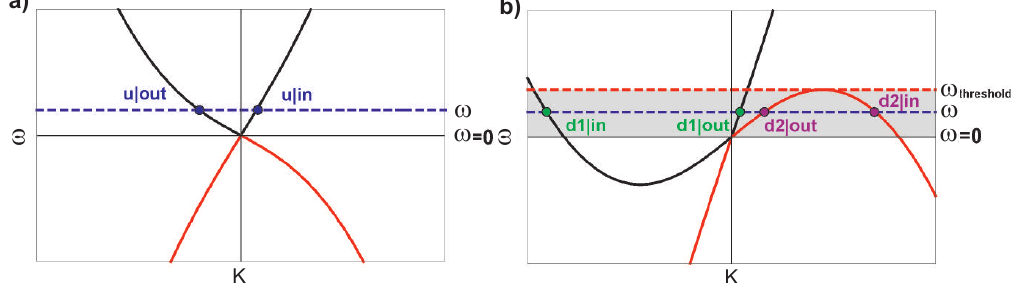
Figure 7: Dispersion relation in the laboratory frame of a BEC analogue: a) high- potential (low flow velocity) region; b low-potential (high flow velocity) region. Black — positive-norm branch; Red — negative-norm